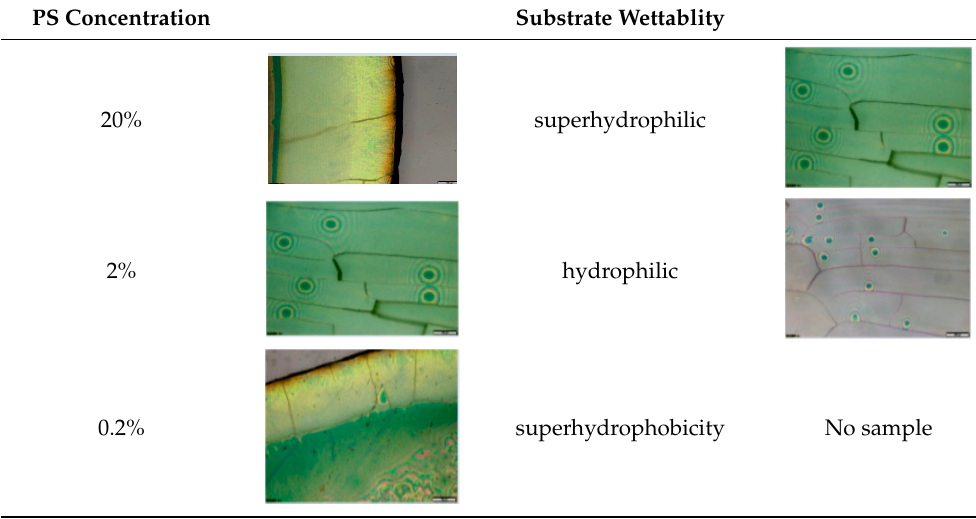
Table 1. The impact of different concentration of Poly (St-MMA-AA) latex and wettability of the top substrate.